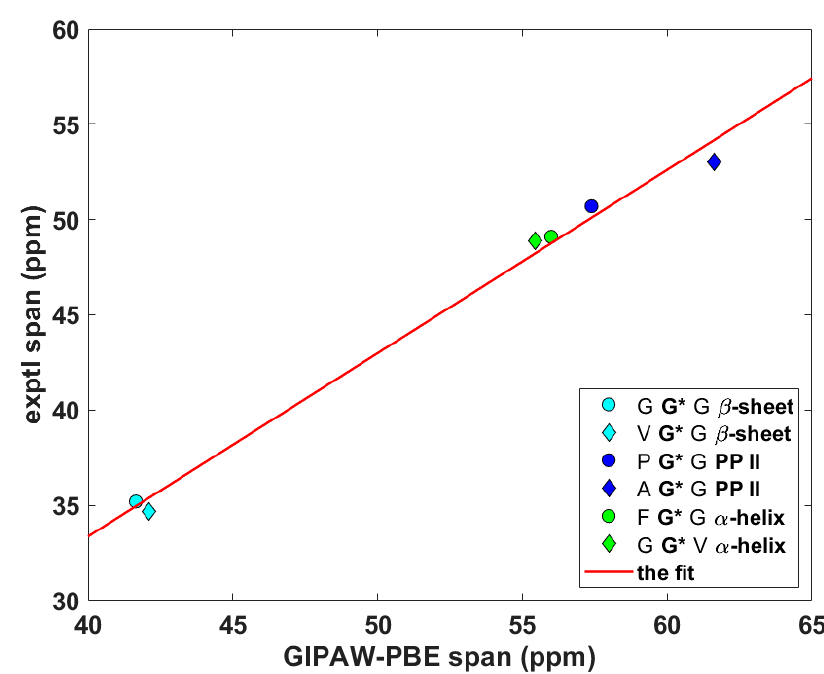
Figure 3. The anisotropic 13 C data of C α nuclei of selected glycyls in tripeptides.